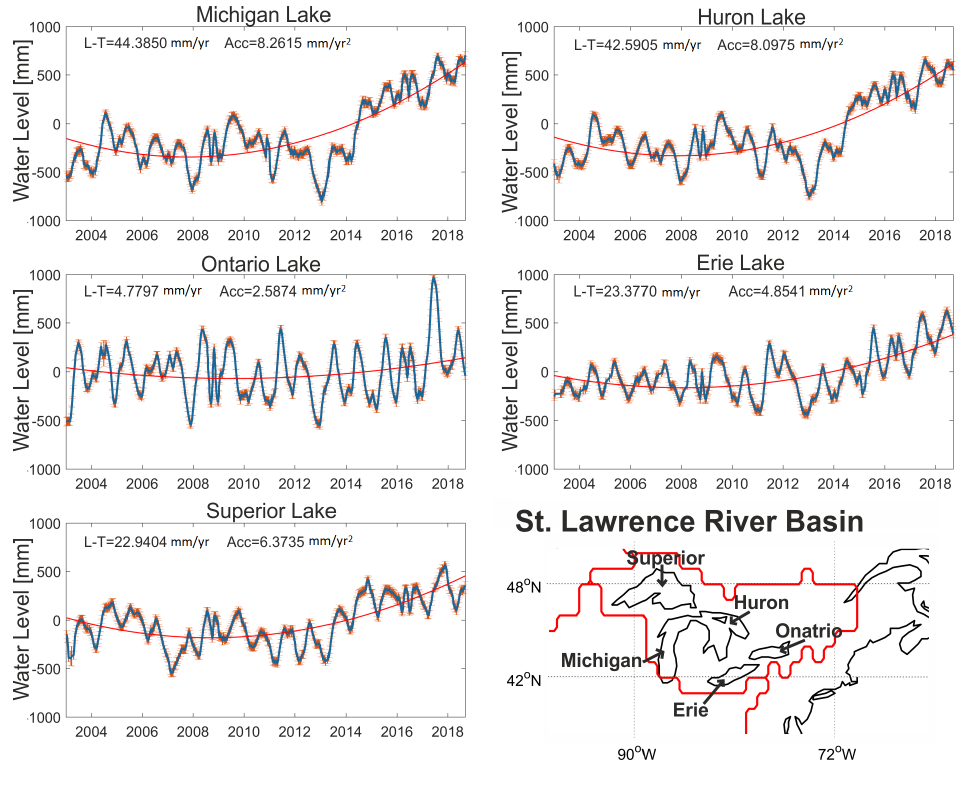
Figure 7. Satellite altimetry observations within the Great Lakes of Superior, Huron, Michigan, Erie, and Ontario within the St. Lawrence River Basin (North America), covering the period of 2003–2018. The red lines show the long-term linear trend and acceleration component fitted to the water level time series using the least squares approach. The values of linear trend (mm/yr) and acceleration (mm/yr 2 ) components fitted to each time series are shown by L-T and Acc, respectively.